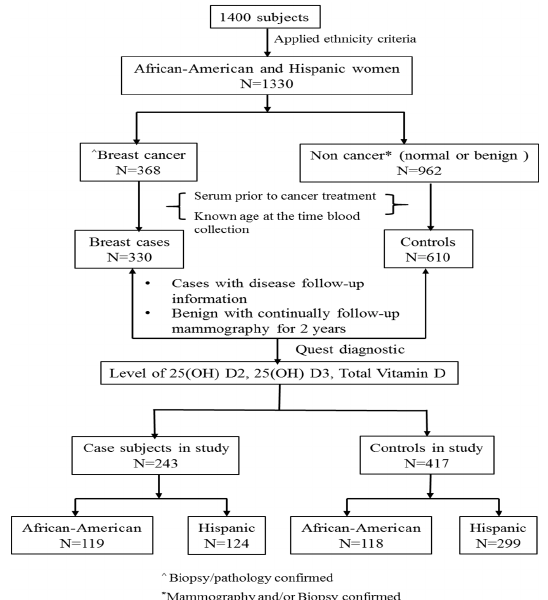
Figure 2. Subjects selection. The flowchart demonstrated subjects’ selection for the study. ^ All